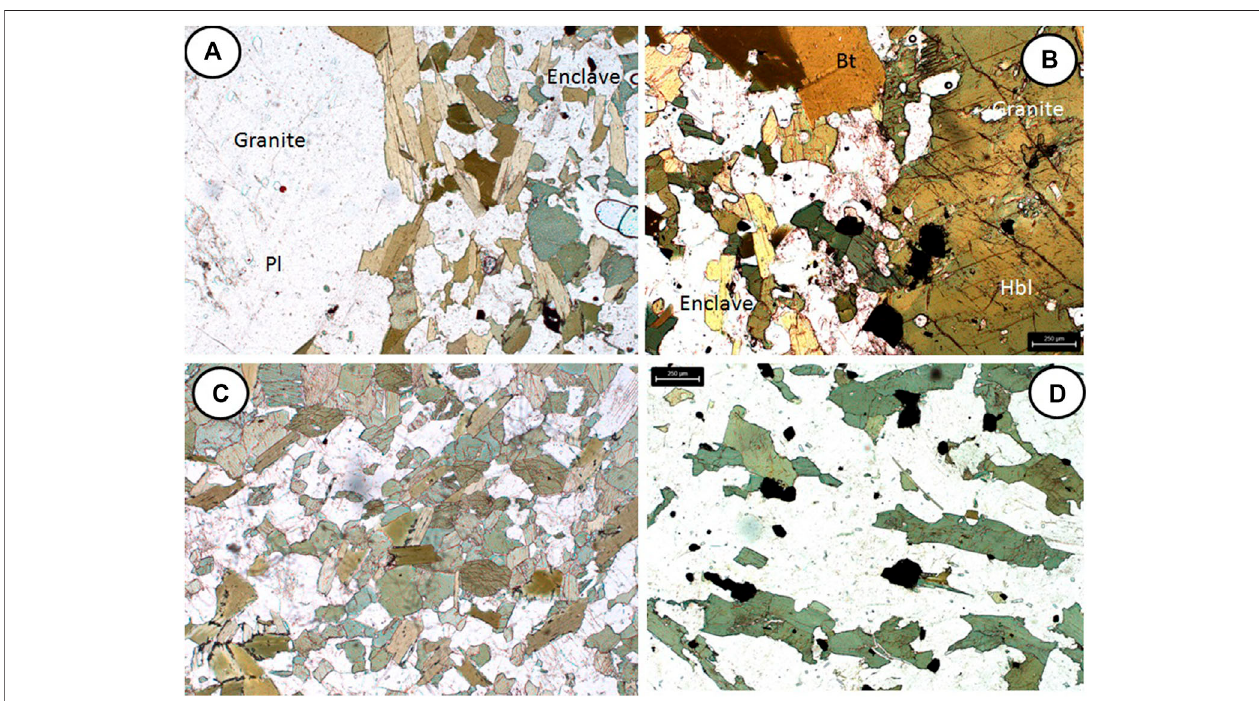
FIGURE8|(A) Microphotographs showingmagmatic textures and contact relationshipsbetweenthe enclave and hostgranite.Note the sharpcontact ofenclave against the plagioclase of granite. Plane polarized. (B) Contact between the enclave and host granite is sharp and crenulated without any reaction signature even at the microscopic level. Crossed polar.The base of the photograph equals 2.5 mm. (C) Ma fi c enclave enriched in amphibole and biotite, which areaggregated at places with interstitial quartz and feldspars. (D) Elongated and anhedral crystals of amphiboles exhibit magmatic fl owage. Note the acicular apatite in the interstitial felsic minerals. Plane polarized. The base of the photograph equals to 2.5